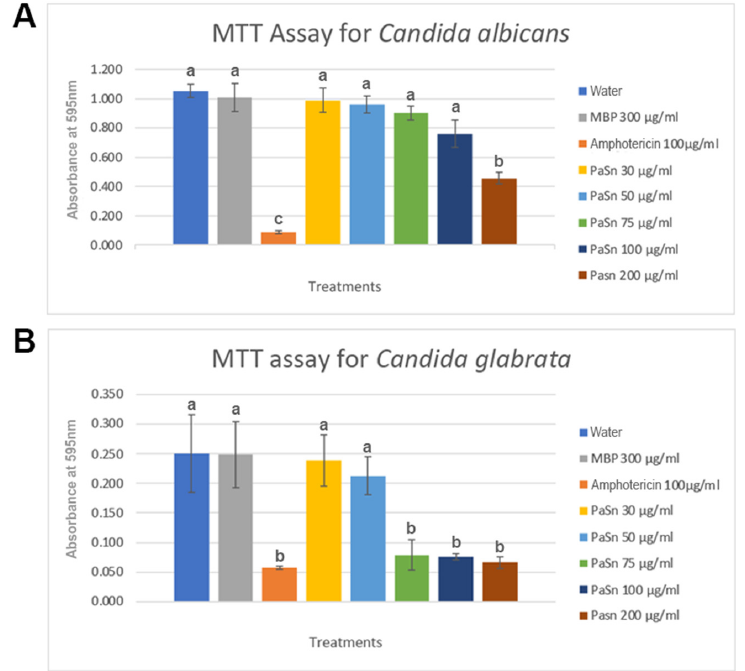
Figure 5. In vitro effects of avocado PaSn recombinant peptide in a human pathogen viability assay. MTT viability assay with different concentrations of PaSn. ( A ) Candida albicans ( B ) Candida glabrata . Each concentration was replicated in three independent experiments. There were significant differences between groups. Multiple group comparisons were tested using analysis of variance (ANOVA) in the SPSS software. Differences were defined as significant at p < 0.05. Different letters indicate a significant difference between groups, while the same letter indicates no difference.